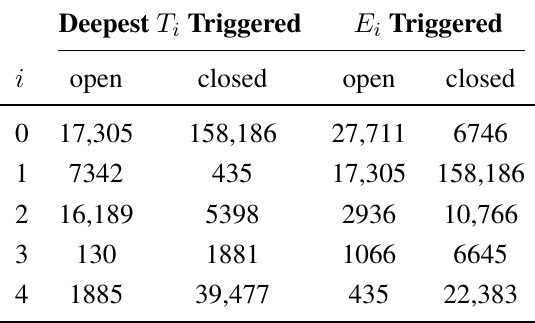
triggered before the algorithm exits and counts for i i